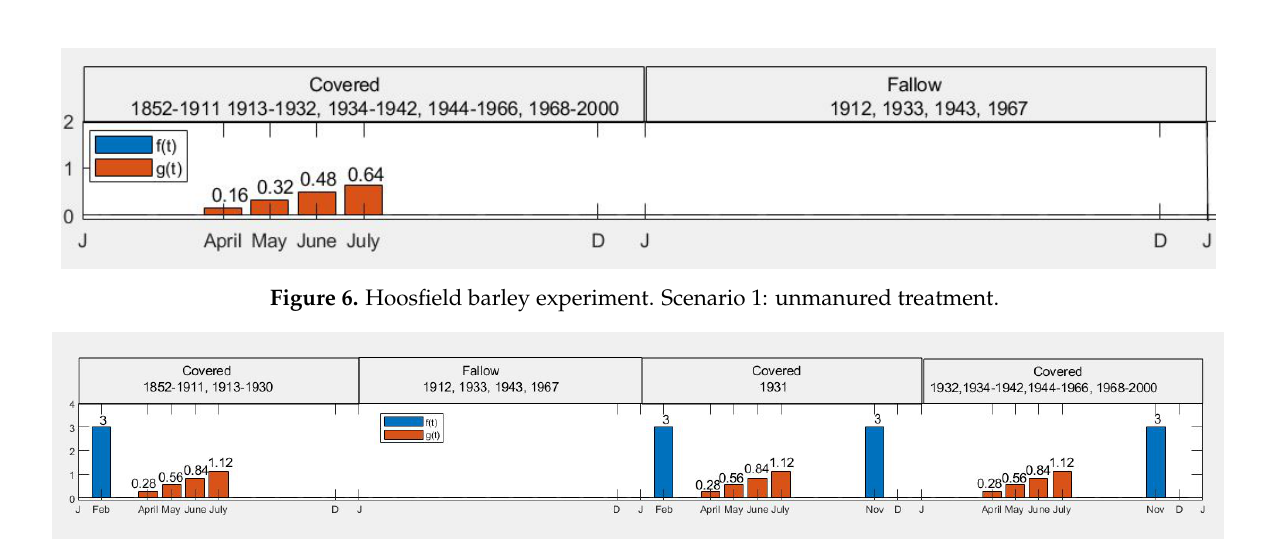
Figure 7. Hoosfield barley experiment. Scenario 2: farmyard manure annually (two times in 1931).